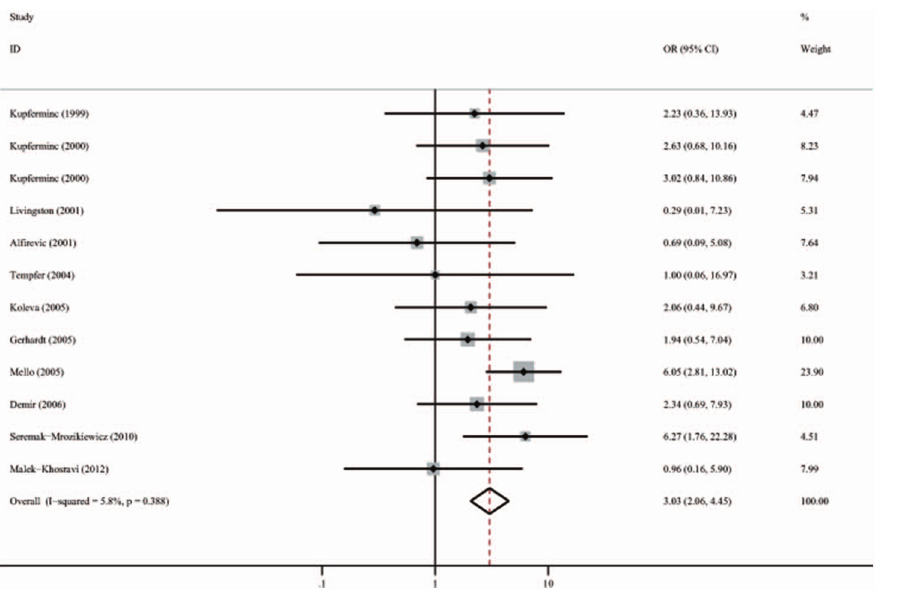
Figure 4. Forest plots of OR with 95%CI of severe preeclampsia associated with the prothrombin G20210A polymorphism in fixed model. Black square means value of OR, and the size of the square means inversely proportional to its variance. Horizontal line means 95% confience interval (CI) of OR. Black diamond means pooled results.